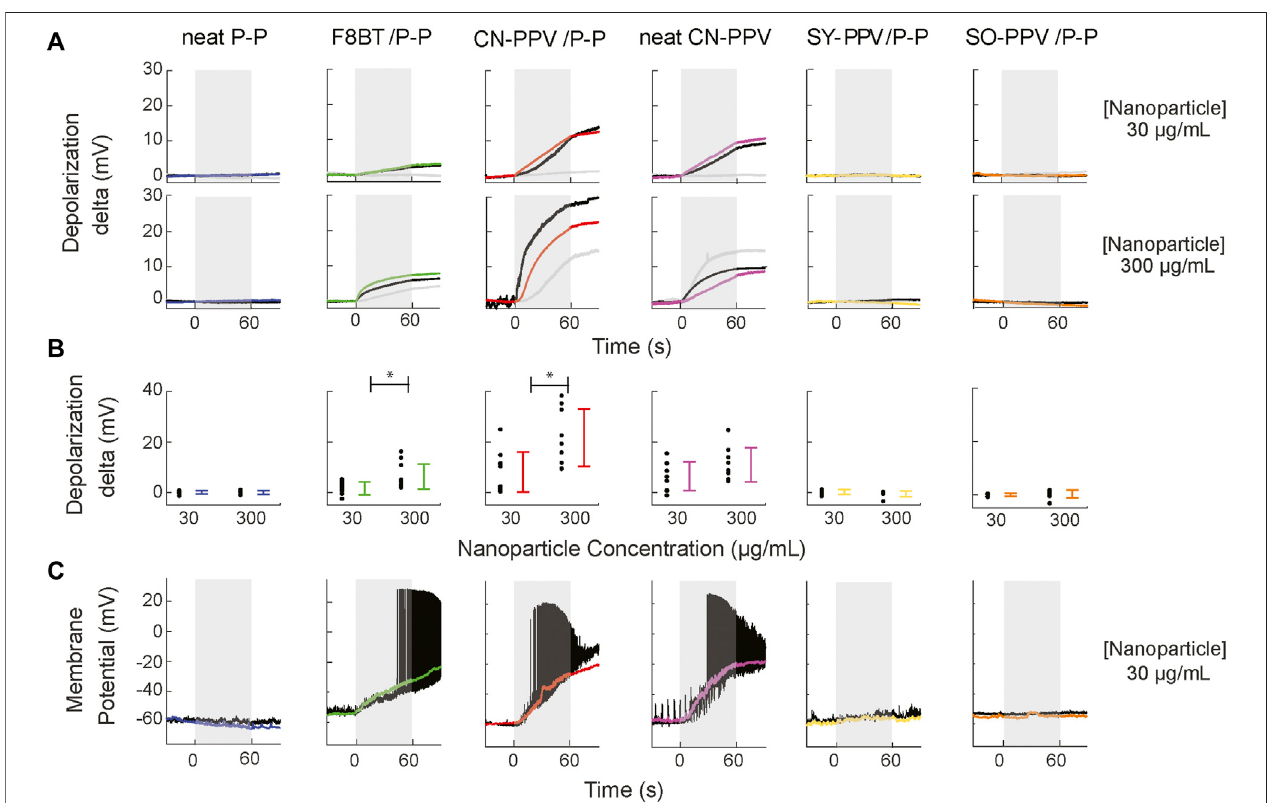
FIGURE6| Membranepotentialresponsetophotoexcitation ofHEK293 and primary neuronsincubated withconjugatedpolymer nanoparticles. (A) Traces ofthe mean responses of HEK293 cells per experimental condition, with gray, black, and colored traces for 0.8, 3.4, and 5 mW/mm 2 (473 nm), respectively N = 3 – 4 cells per irradiance. Recordings in top and bottom rows correspond to cells incubated with CNP concentrations of 30 and 300 μ g/ml, respectively. (B) Concentration- dependence of depolarization of HEK293 cells. (C) Depolarization elicited by photostimulation of primary neurons incubated with CNPs. Black traces show representative traces of neuronal responses; colored lines show the mean response low-pass fi ltered at 100 Hz (N = 3 – 4 neurons per condition).